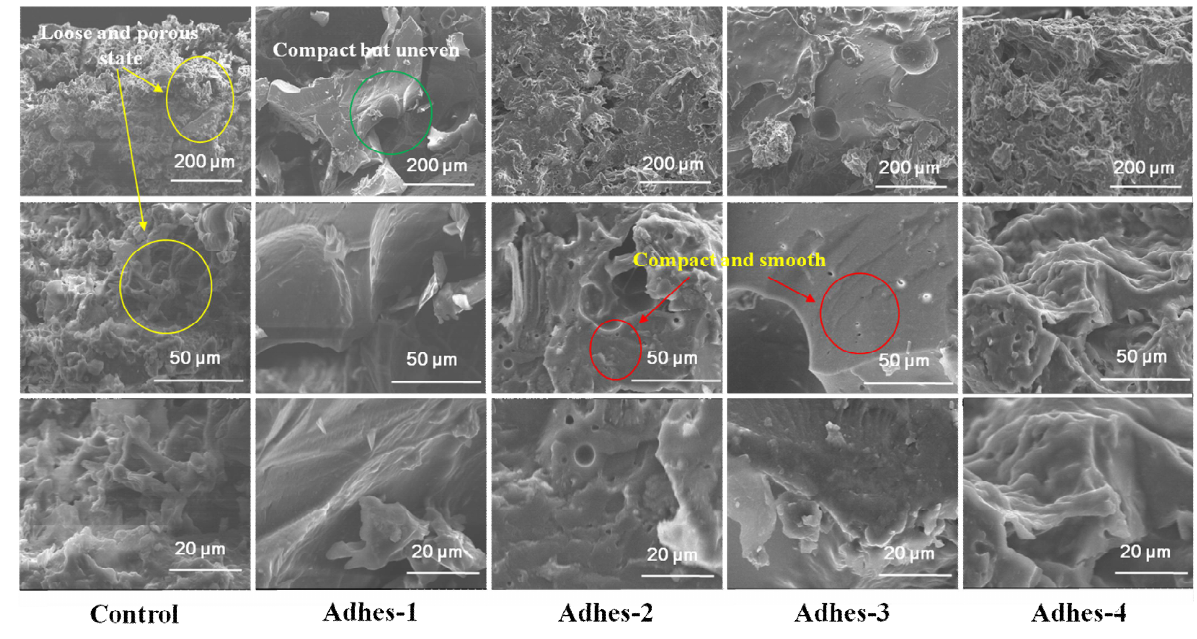
Figure 4. SEM images of fractured cross-sections of cured Camellia oleifera cake-protein adhesives. Note: Control, pure Camellia oleifera cake-protein hydrolysate; Adhes-1, the pure Camellia oleifera cake-protein adhesive; Adhes-2, Camellia oleifera cake-protein adhesive modified with DSP; Adhes-3, Camellia oleifera cake-protein adhesive modified with SPI; Adhes-4, Camellia oleifera cake-protein adhesive modified with casein.